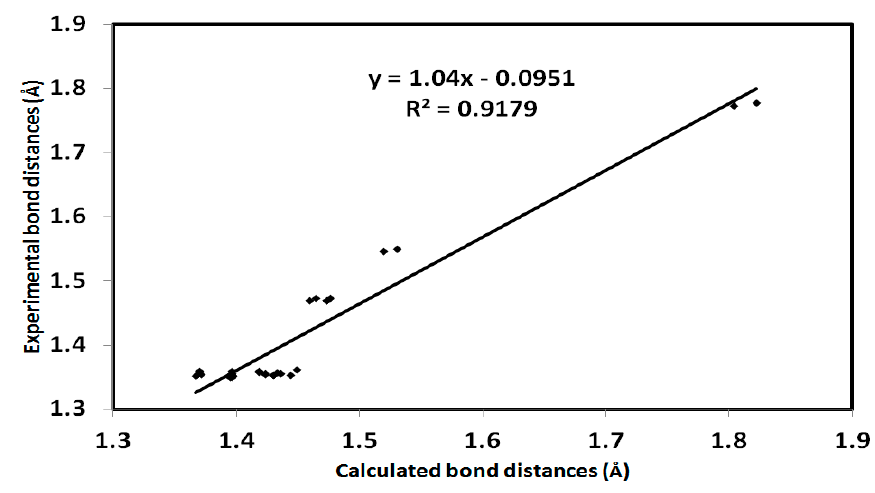
Figure 8. Correlation diagram of the computed bond distances and the experimental values of aza- Michael product 3 . The correlation coefficient for bond angles is 0.835.